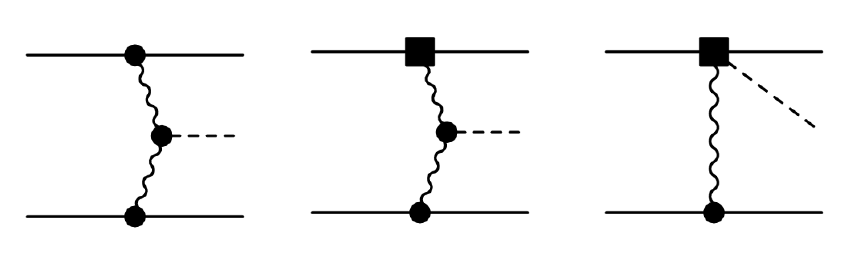
Figure 5 . Leading order contribution to Higgs production via vector boson fusion. Dots denote SM vertices, while squares denotes an insertion of (cid:24)